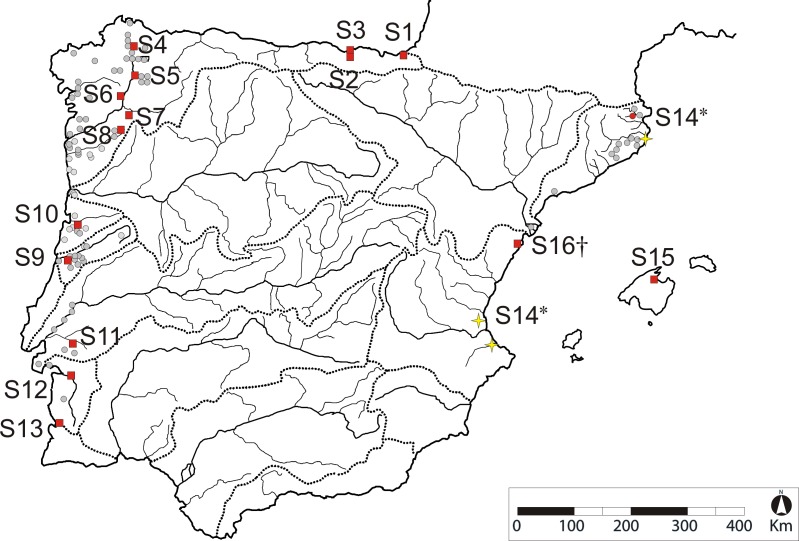
Approximate distribution area of G. aculeatus across Portugal and Spain (redrawn from Ribeiro et al. [13] and Doadrio et al. [23]).Readers are referred elsewhere [16, 25–27] for a more detailed geographic distribution of the species in Northern Spain. Boundaries of icthyographic provinces are marked by dotted lines. Sampling locations surveyed for the present study (red squares) are coded as in Table 1. Yellow stars correspond to localities where the species has been reintroduced. The asterisk (S14*) indicates that the sample we analysed (Valencia, yellow star) comes from an ex-situ breeding program, using individuals from Catalonia (red circle). The cross indicates that site Penyscola (S16) went extinct in the early 1990’s.